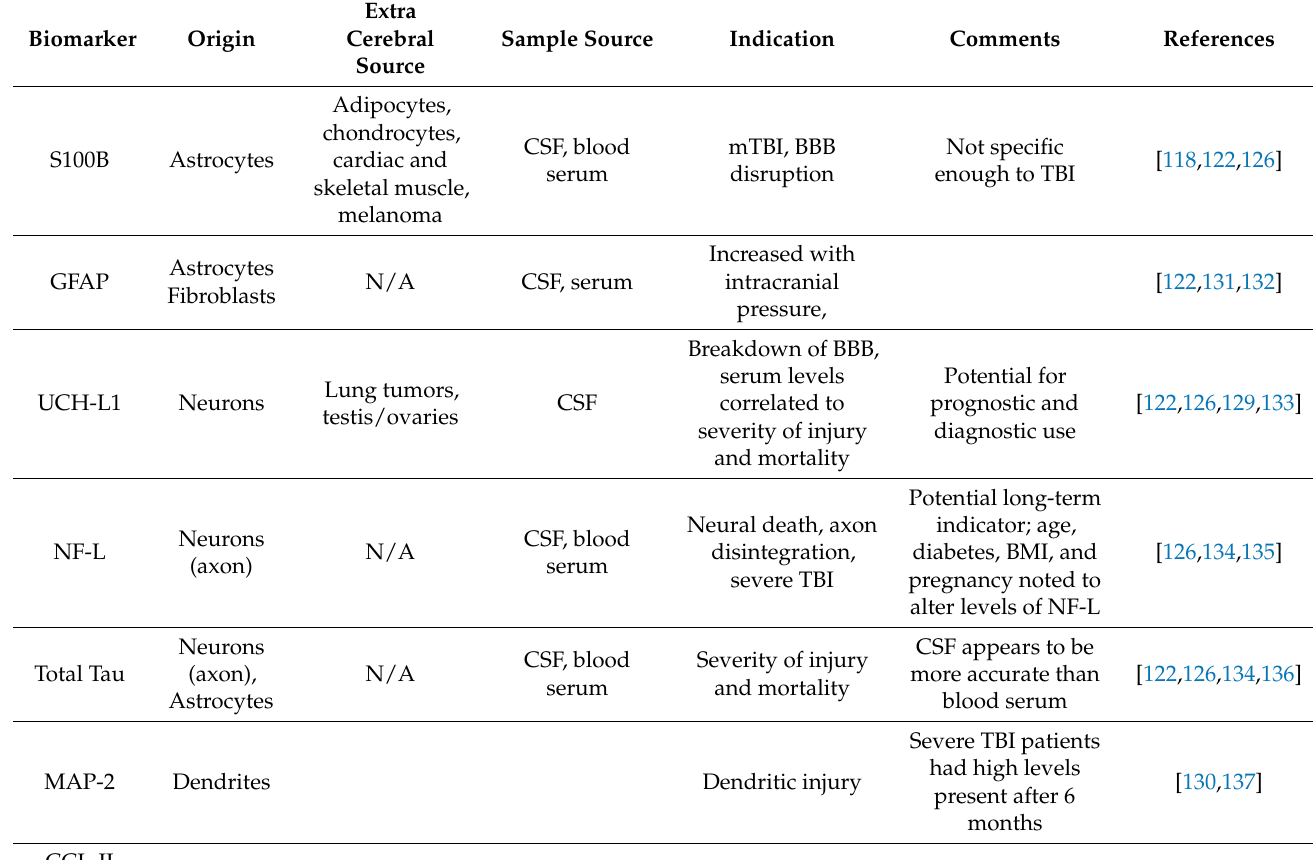
Table 6. Biomarker origin, fluid source, indications, and comments specific to